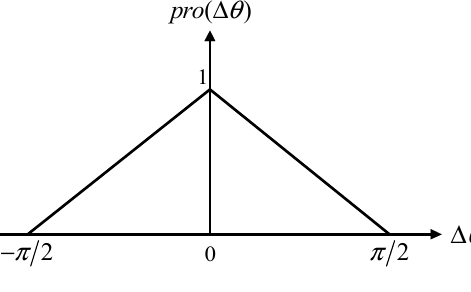
Figure 3. Distribution of parallel index.